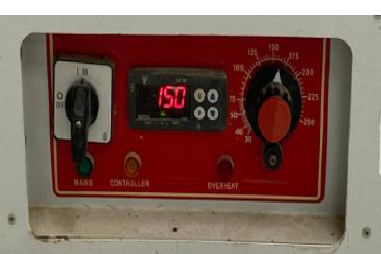
Figure 18. Puttting the hot mix sample in the mould